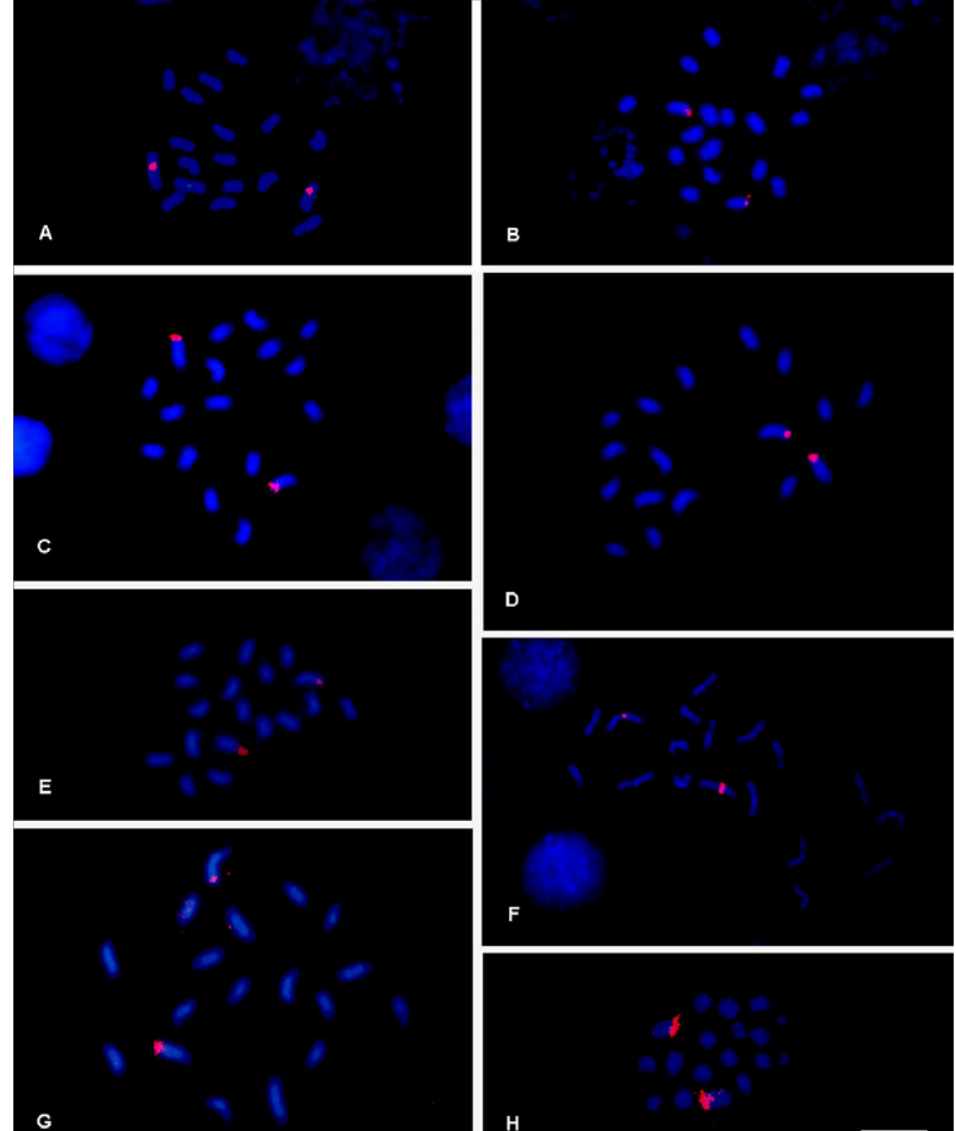
Fig 5 . FISH with 45S rDNA in metaphases of M. quadrifasciata (A), Melipona aff. flavolineata (Xapuri- AC 1 ) (B), M. aff. flavolineata (Brasiléia-AC) (C), M. aff. flavolineata (Xapuri-AC 2 ) (D), M. aff. flavolineata (Capixaba-AC) (E), Melipona bicolor (F), Melipona crinita (G) and Melipona nebulosa (H). Bar = 10